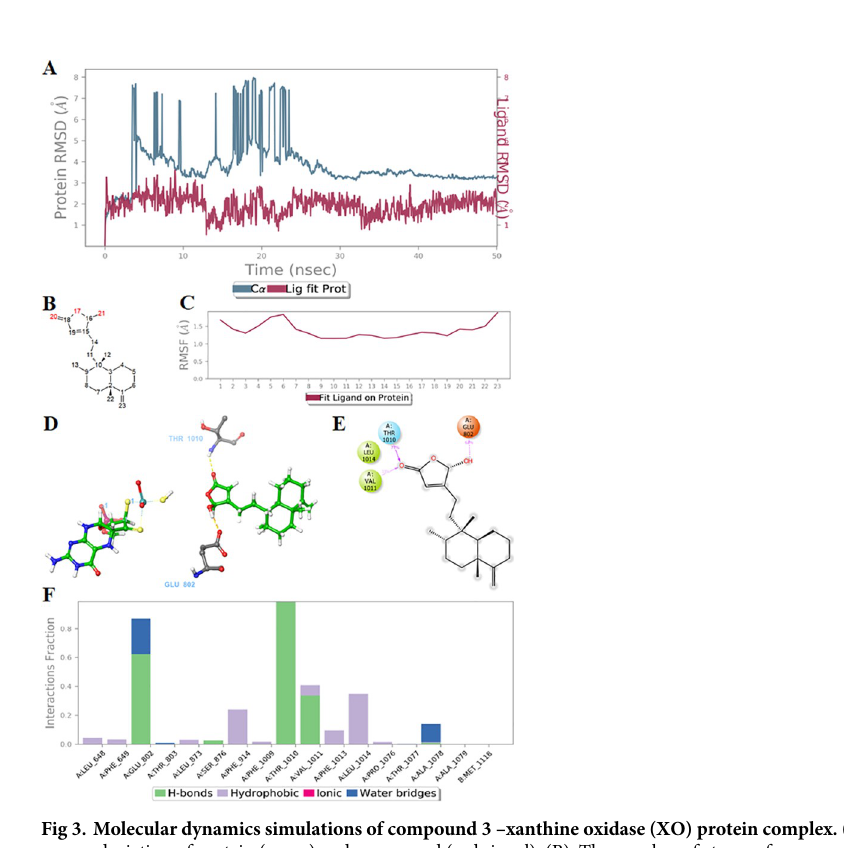
Fig 2. Docking interactions of compounds 3 and 4 against XO protein. (A) The distances between Mo complex and allopurinol (green and blue), compound 3 (mangenta), compound 4 (teal); Binding poses of (B) compound 3; (C) compound 4; and (D) allopurinol drug with XO protein. The additional informations in 2D diagrams present.